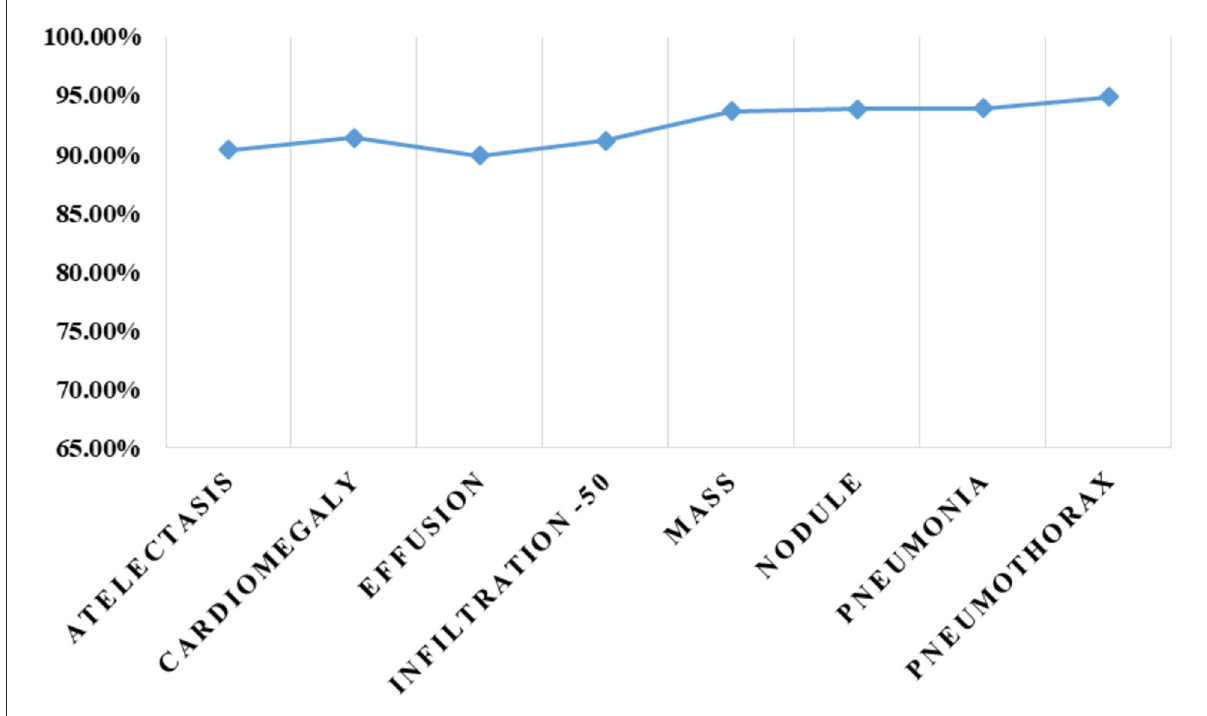
FIGURE14 Class-wise accuracy values.